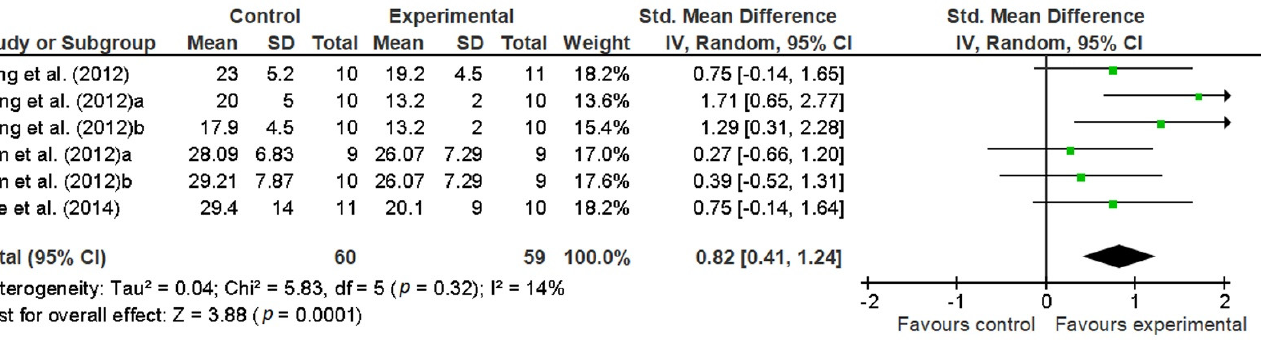
Figure 2. Pooled standardized mean differences and overall effect size (95% CI) on the TUG test immediately after the intervention.